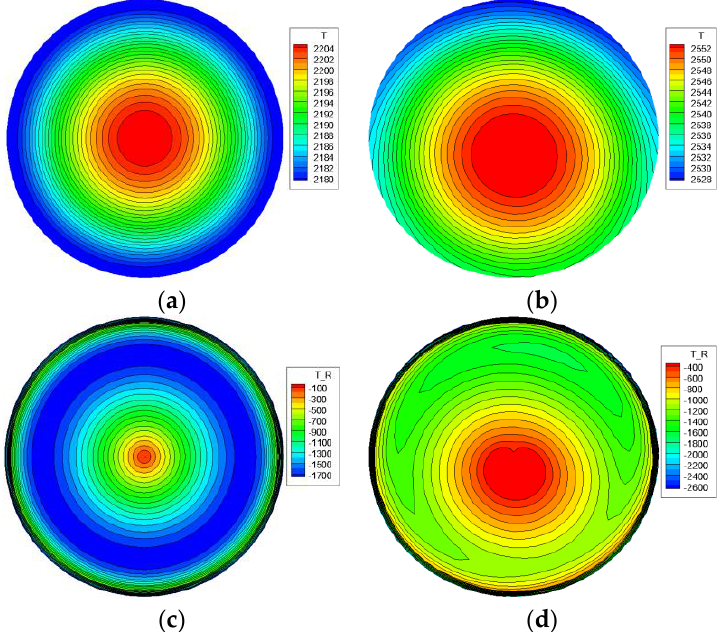
( b ) Figure 9. Temperature field at I = 1250 A and F = 16 kHz. ( a ) Axisymmetric coil; ( b ) spiral coil.